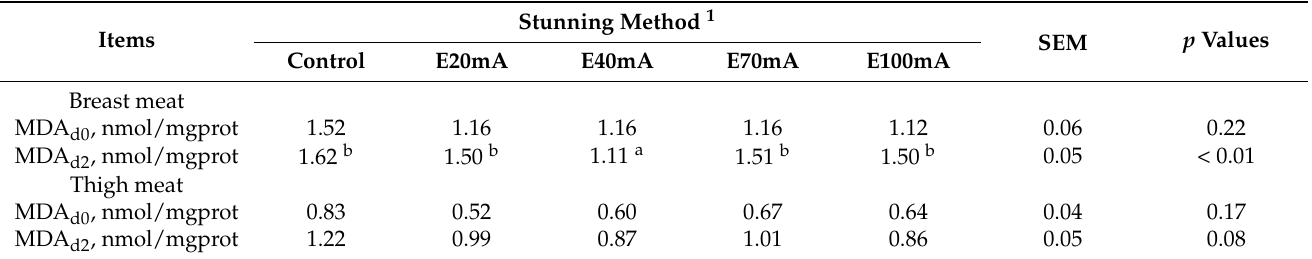
Table 3. Effects of electrical current intensities on malondialdehyde (MDA) in goose meat at 0 to 2 days